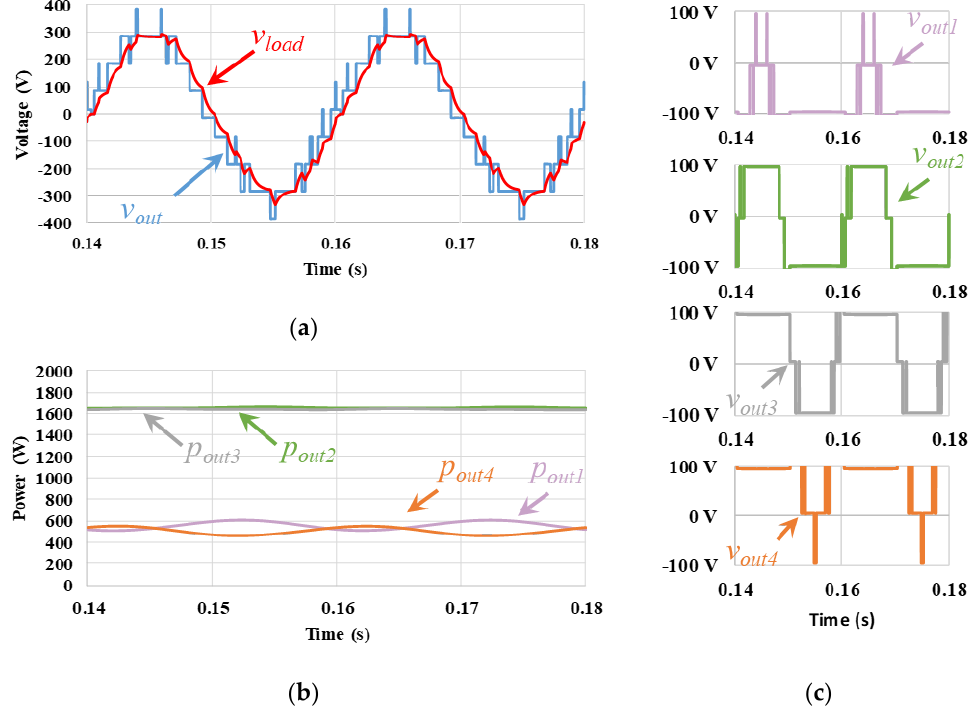
Figure 21. Simulation results of the VF2 PWM technique: ( a ) output voltage of the cascaded MLC, v out , and load voltage, v load ; ( b ) output power on each submodule ( p out1 , p out2 , p out3 , p out4 ); ( c ) output voltage on each submodule ( v out1 , v out2 , v out3 , v out4 ).